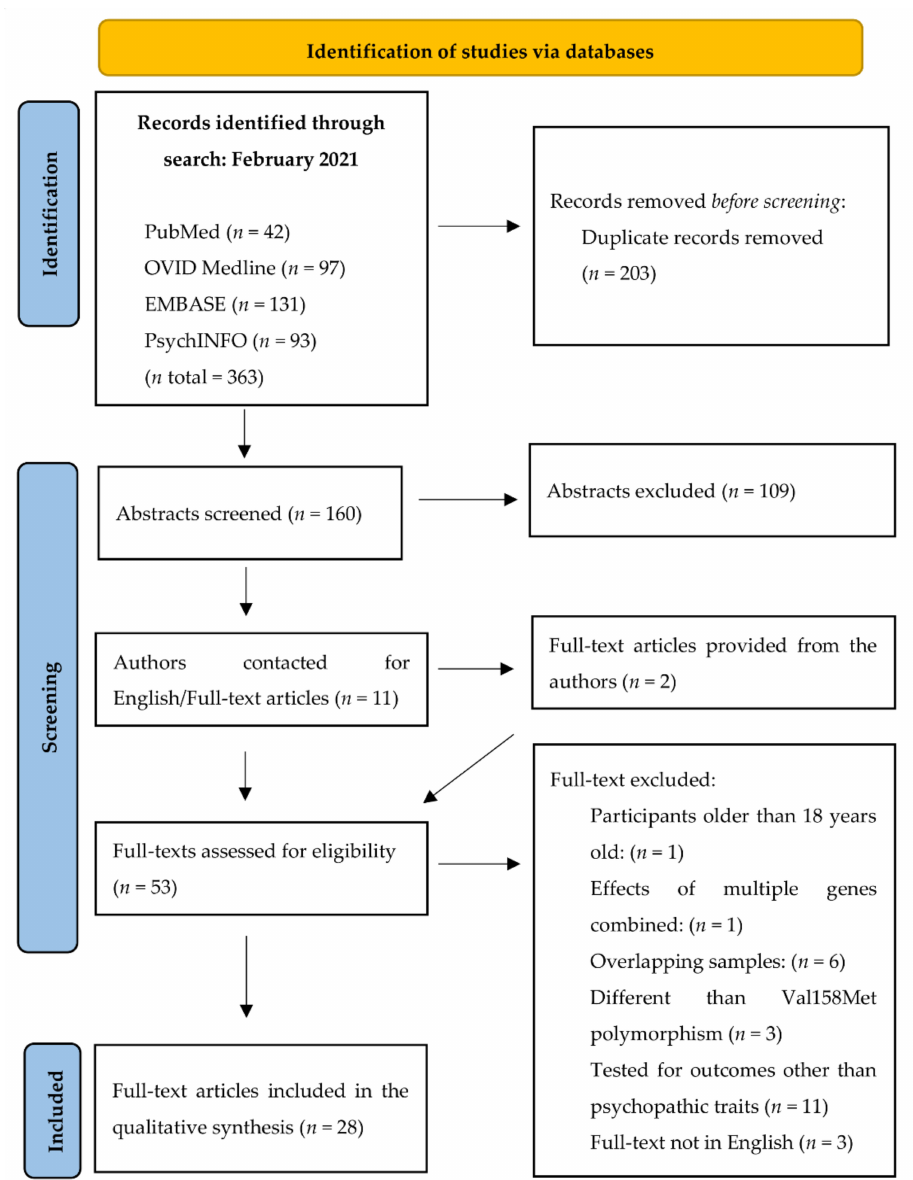
Figure 1. PRISMA flow diagram of the systematic review with inclusion and